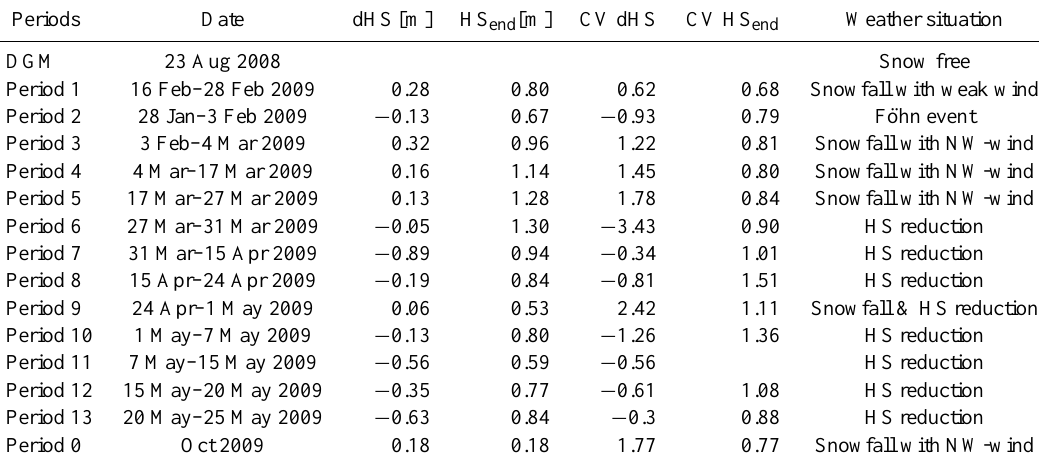
Table 3. Observation periods in the southwest face of the Ch¨upfenflue: name of the period, date, mean snow depth change of the snow covered cells (dHS, in m), snow depth at the end of the period (HS end , in m), coefficient of variation of the snow depth change (CV dHS) and coefficient of variation of HS end (CV HS end ) and the main weather